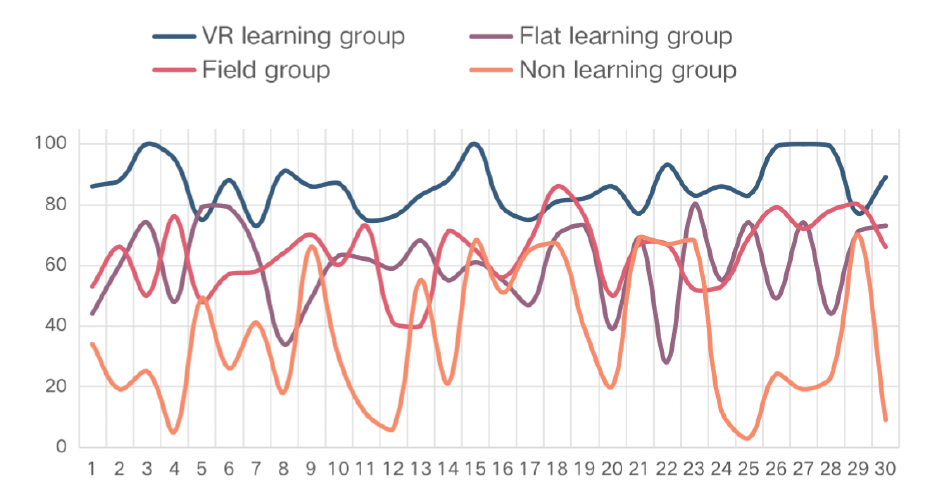
Figure 12. Scores of the